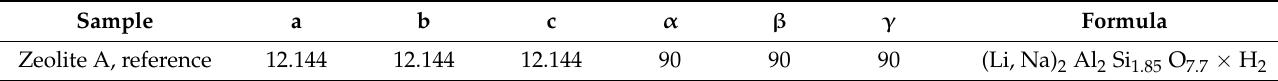
Table 1. Lattice constant of zeolite A.